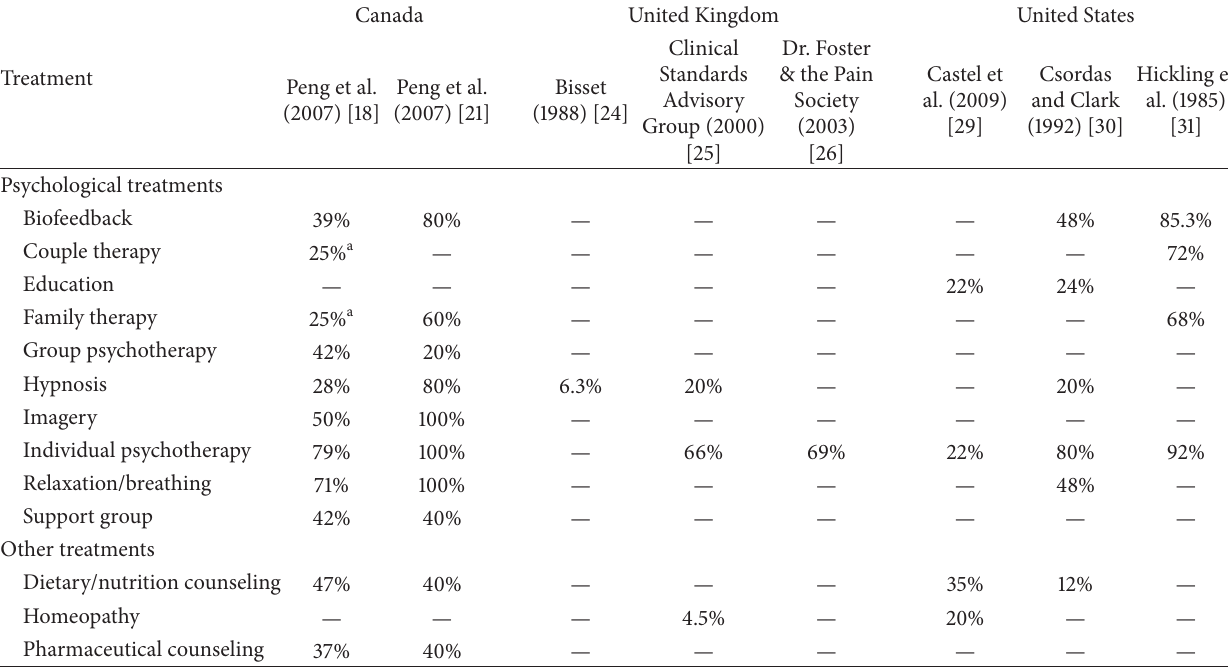
Table 6: Psychological treatments and other treatments used at pain treatment facilities.